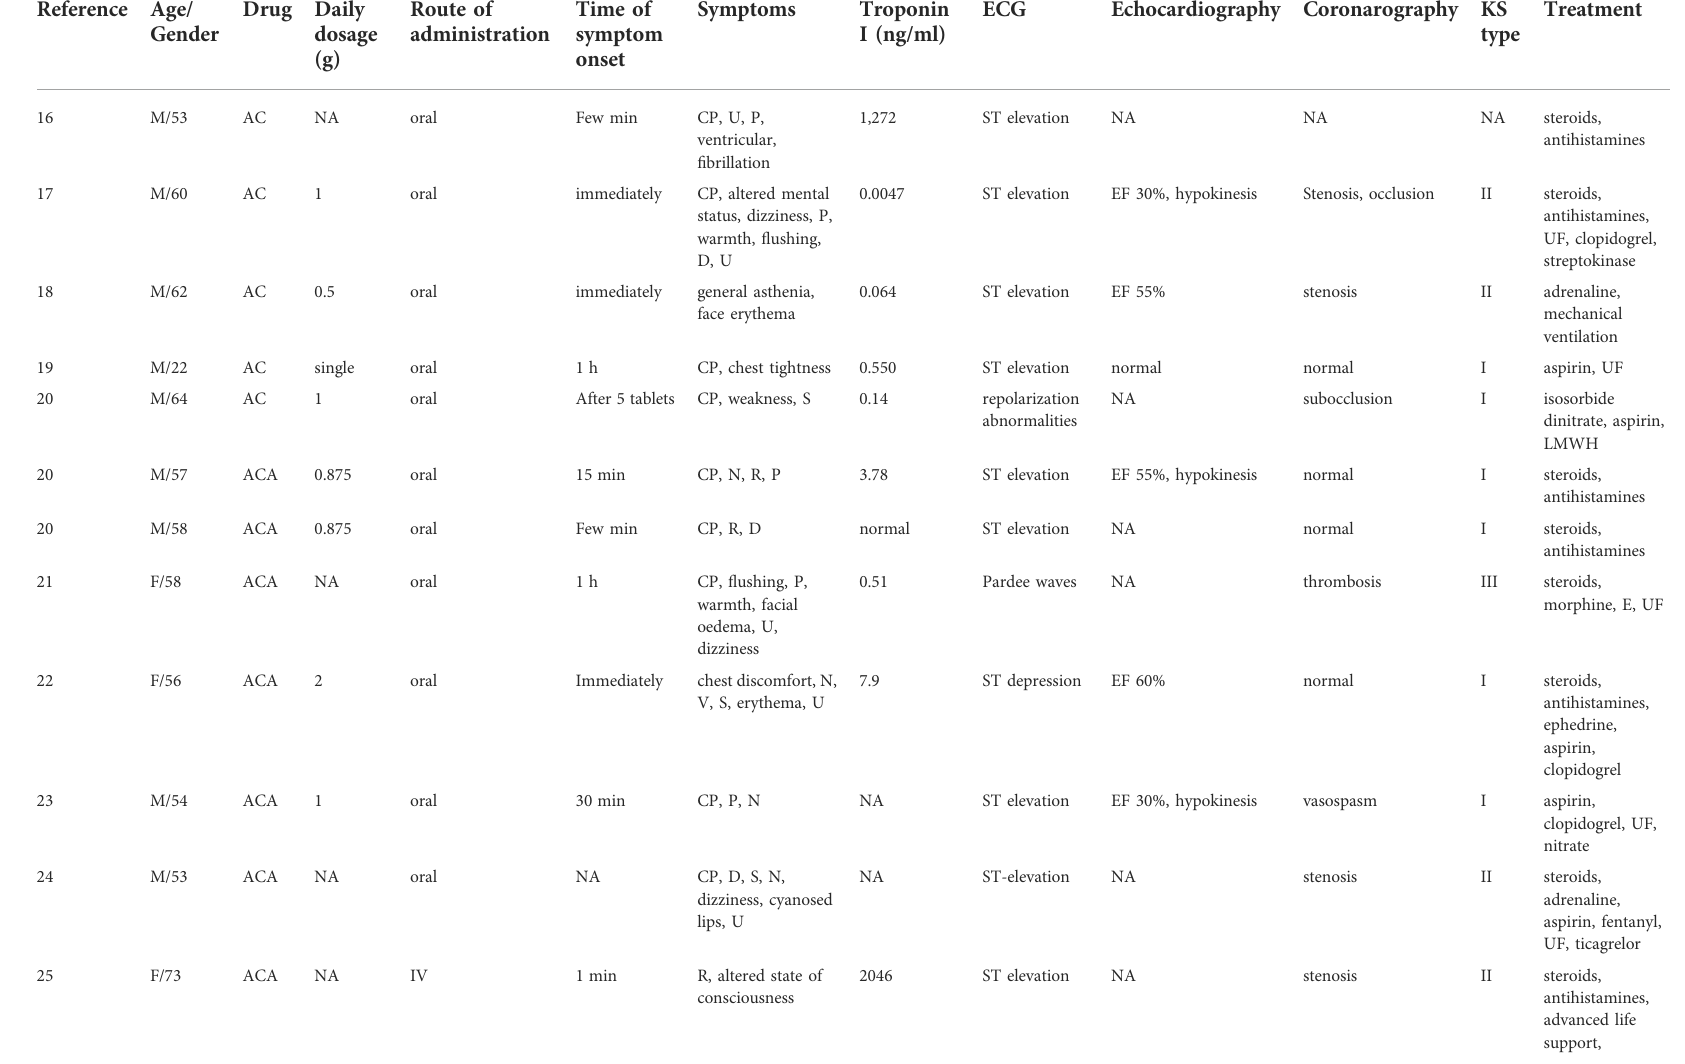
TABLE 1 ( Continued ) Summary of clinical information of 33 patients with amoxicillin-induced Kounis